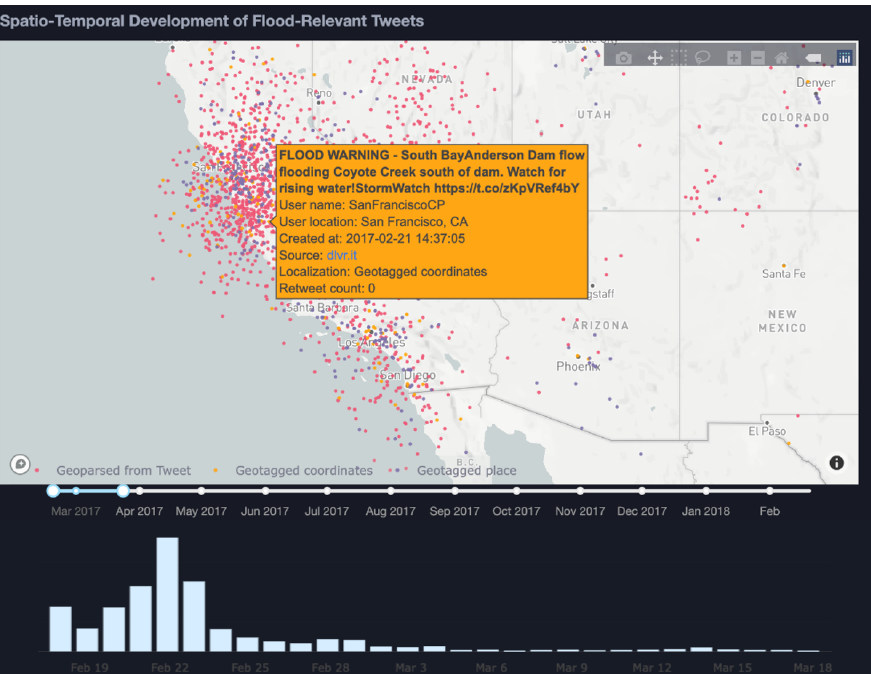
Figure 12. Scatter map showing the concentration of tweets in relation to the Coyote Creek